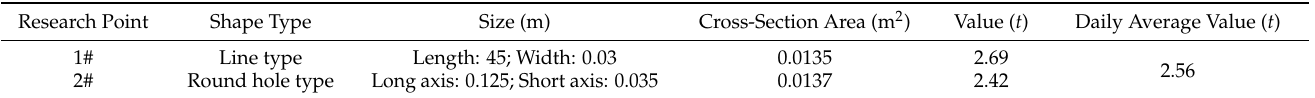
Table 4. Fissure channel carbon